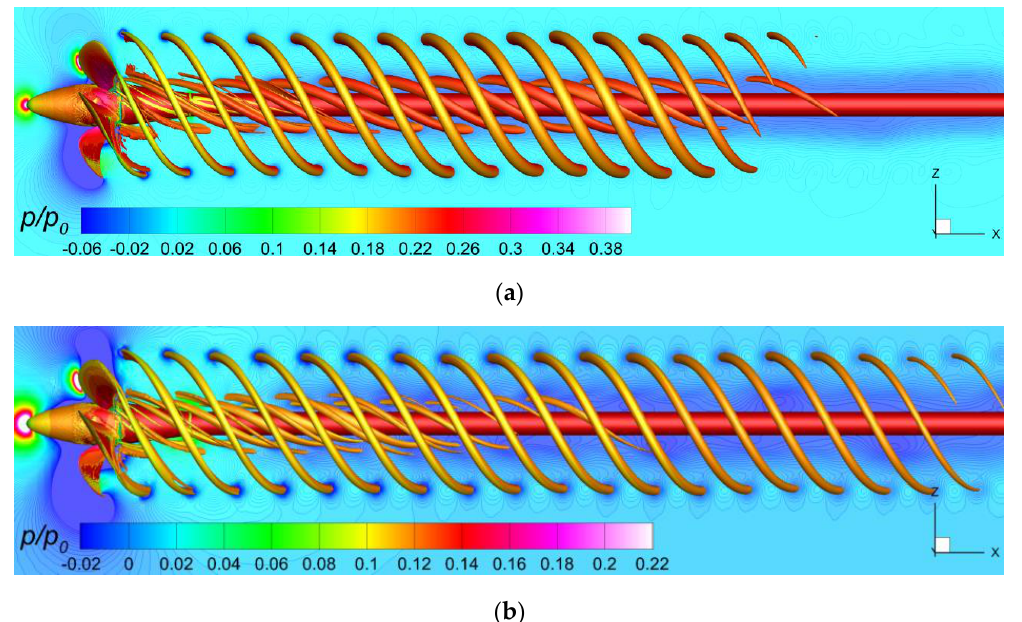
( b ) Figure 6. 𝑦 + distribution on the propeller blades computed at 𝐽 = 0.6418 . ( a ): pressure side; ( b ): suction side. Definitely, the pressure field developed in the wake is always strictly related not only to the